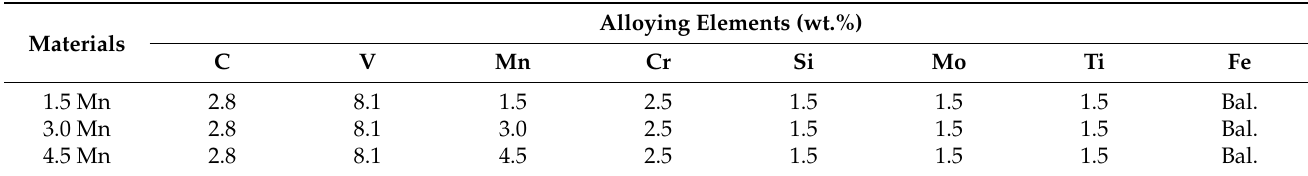
Table 1. Chemical compositions of the VCFCs with different Mn content (wt.%). Alloying Elements